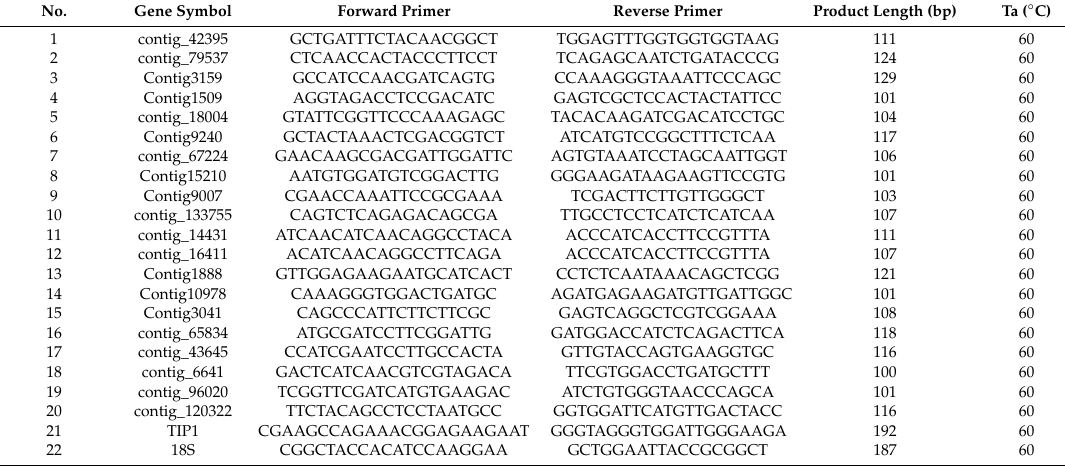
Table 7. Primers used in real-time quantitative PCR